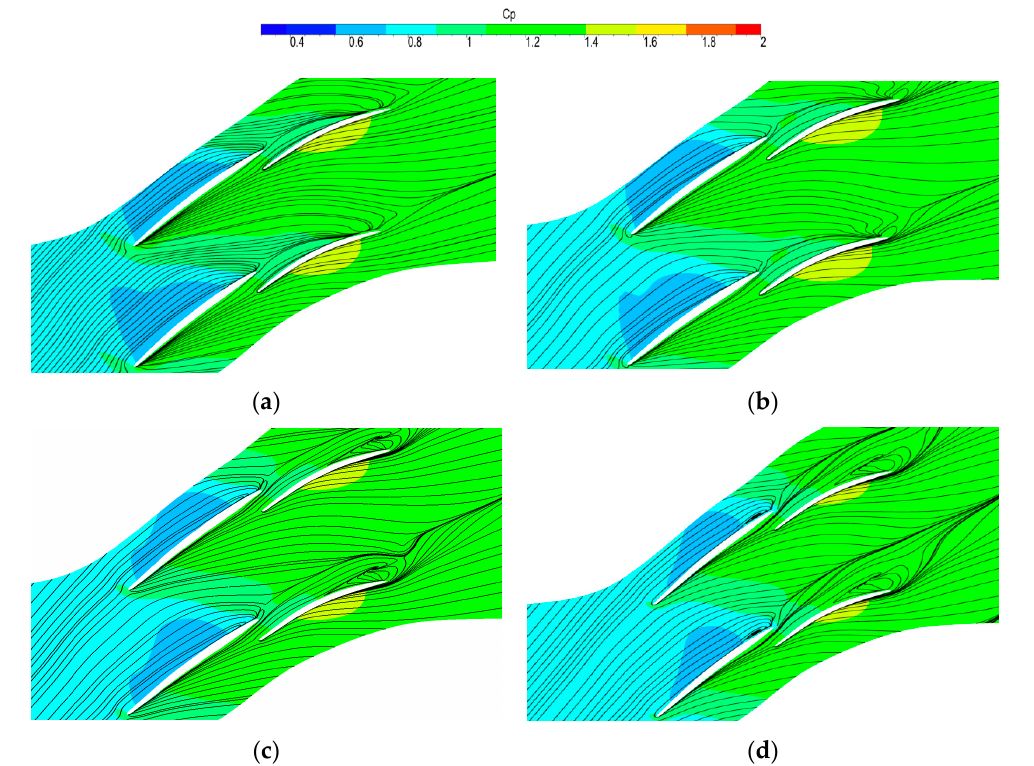
Figure 12. Comparison of flow line and static pressure diagram on the end-wall surface of the hub of NB10, NB20, and NB30. ( a ) ORG. ( b ) NB10. ( c ) NB20. ( d ) NB30.